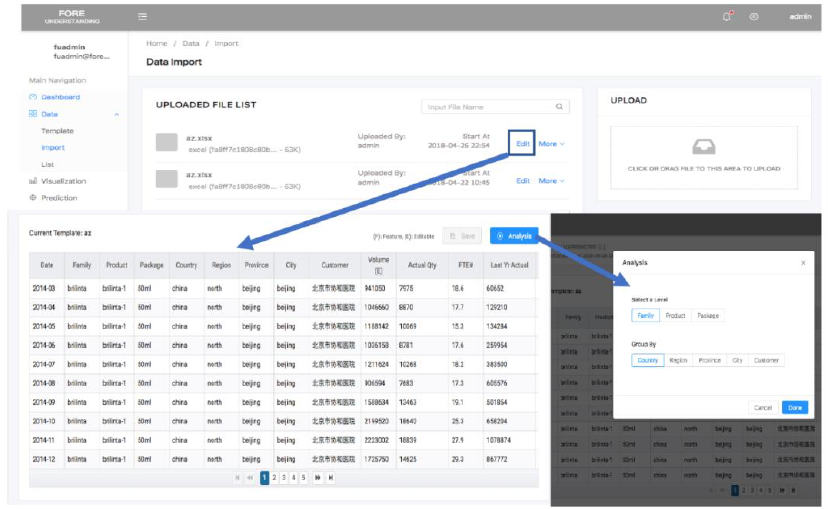
Figure A4. Loading the real sales prediction data set (csv or Excel format). View of the data import, data edit, and data group modules.